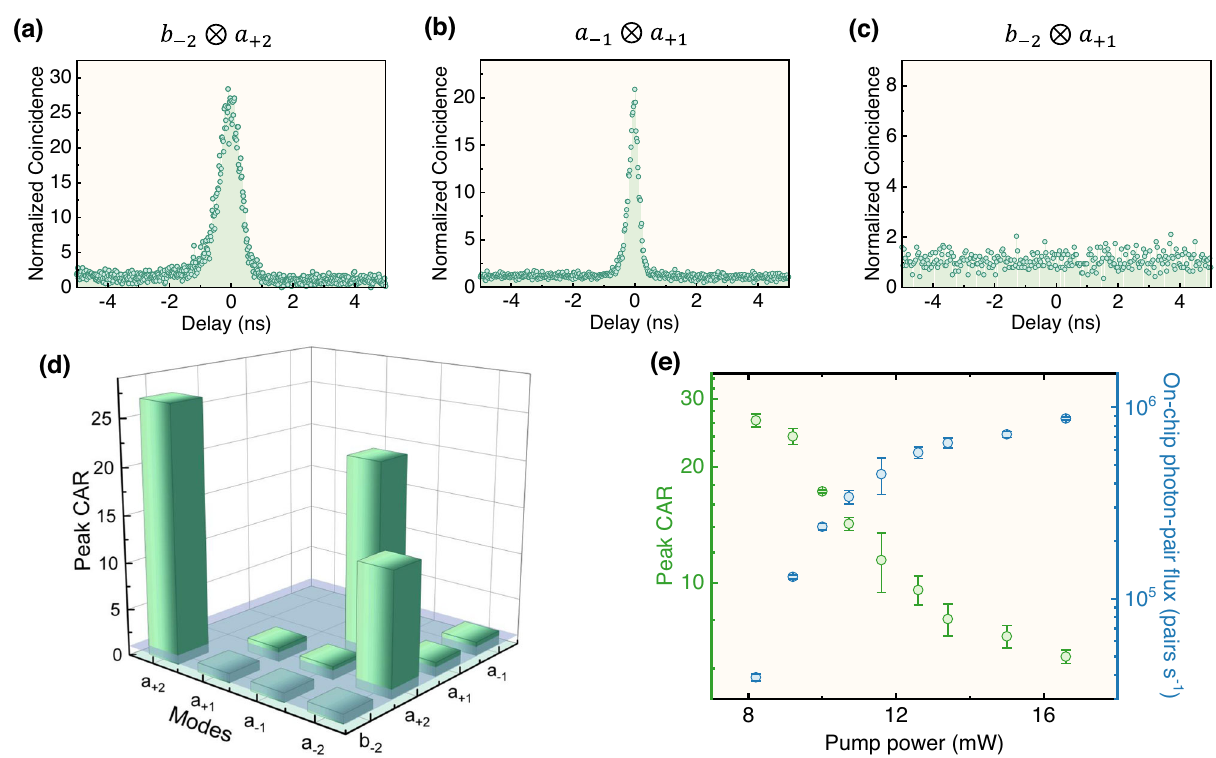
Fig.3|Photon-paircoincidence.a – c Normalizedcoincidencespectrafordifferent mode pairs.The mean background levels (that is, accidental counting) are nor- malized to 1and the normalized coincidencemeans the ratioof coincidence count to background. The on-chip pump power is 8.2mW. d The peak coincidence to